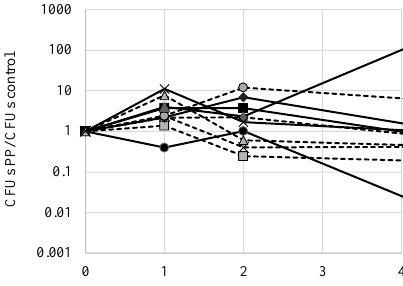
Figure 8. Phenylpyruvate does not affect culture viability. Yeast cells were inoculated to Synthetic Complete medium overnight, then inoculated to MM2 medium with 500 mg L −1 phenylpyruvate, or no drug, and incubated at 37 °C in an immobile 96-well plate. Culture viability was assessed over time using the Tadpoling method. To calculate the CFUs PP/CFUs control, the number of CFUs in phenylpyruvate treated cultures was divided by the number of CFUs in the untreated culture for each day. The average of three independent trials is shown. Markers are the same as used in Figure 7. In S. cerevisiae , one method of increasing the production of the valuable chemical phenylethanol is to select for resistance to FPA [2]. We wanted to test whether FPA resistant strains obtained herein would produce high amounts of phenylethanol. To do this, we inoculated strains into medium